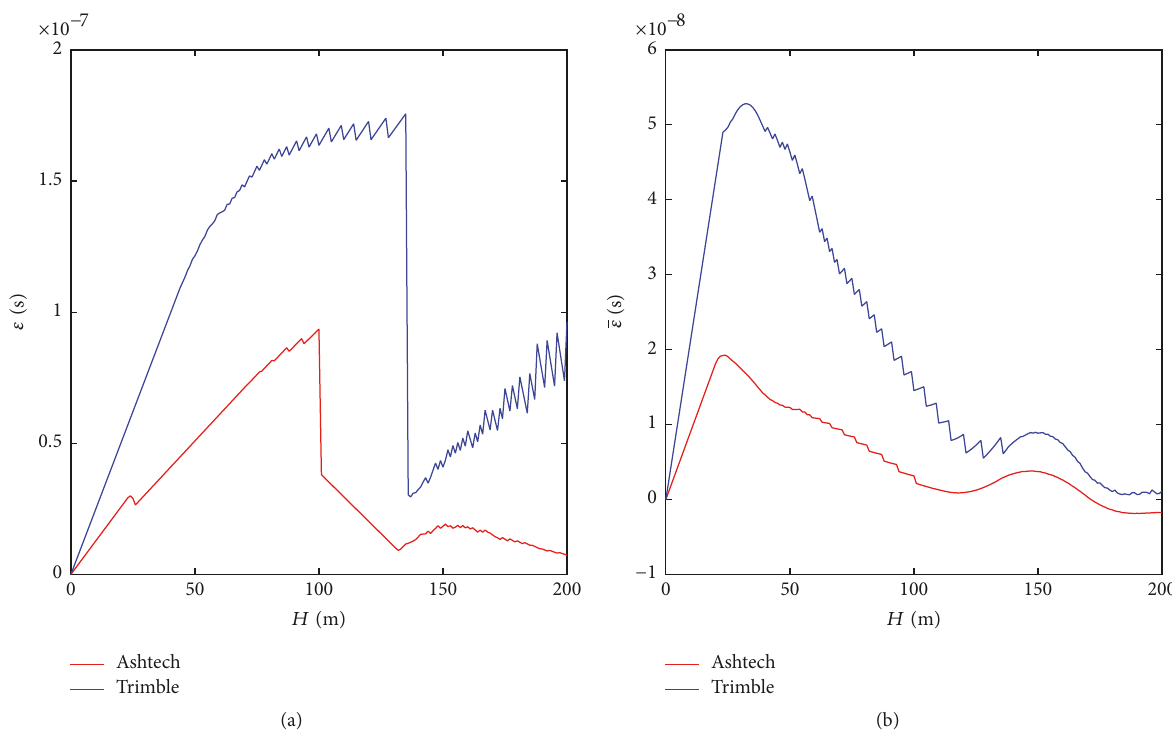
Figure 8: This figure shows how the PPE varies with the antenna height 𝐻 . In this figure, the width 𝑇 𝑐 of the chip is set to 1/1.023𝑒6 as the chip width of C/A code in GPS; the interval of correlators is 𝑑 = 0.25𝑇 𝑐 . (a) is the maximum PPE. (b) is the average PPE.